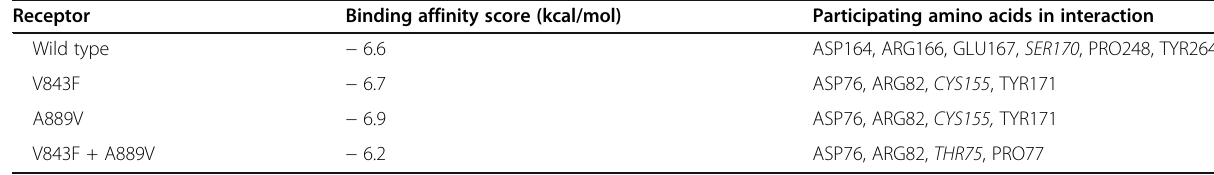
Italicized residues interacted via hydrogen bonds.